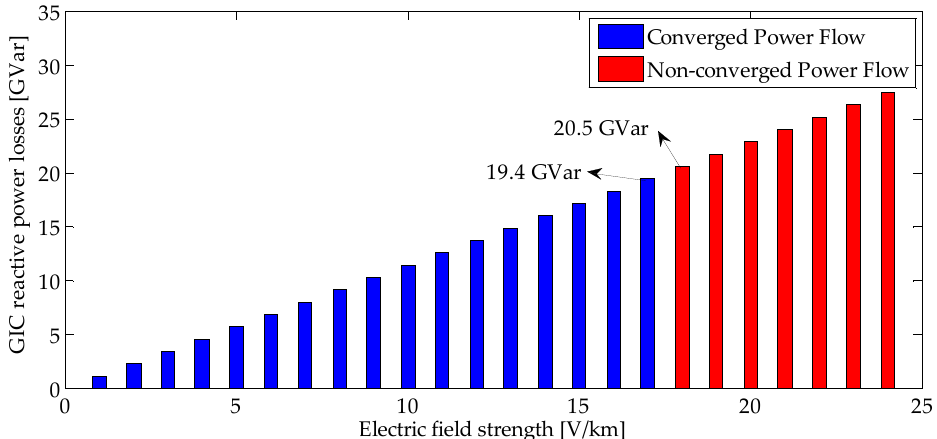
Figure 5. Effect of increasing the electric field strength on geomagnetically-induced current (GIC) reactive power losses.